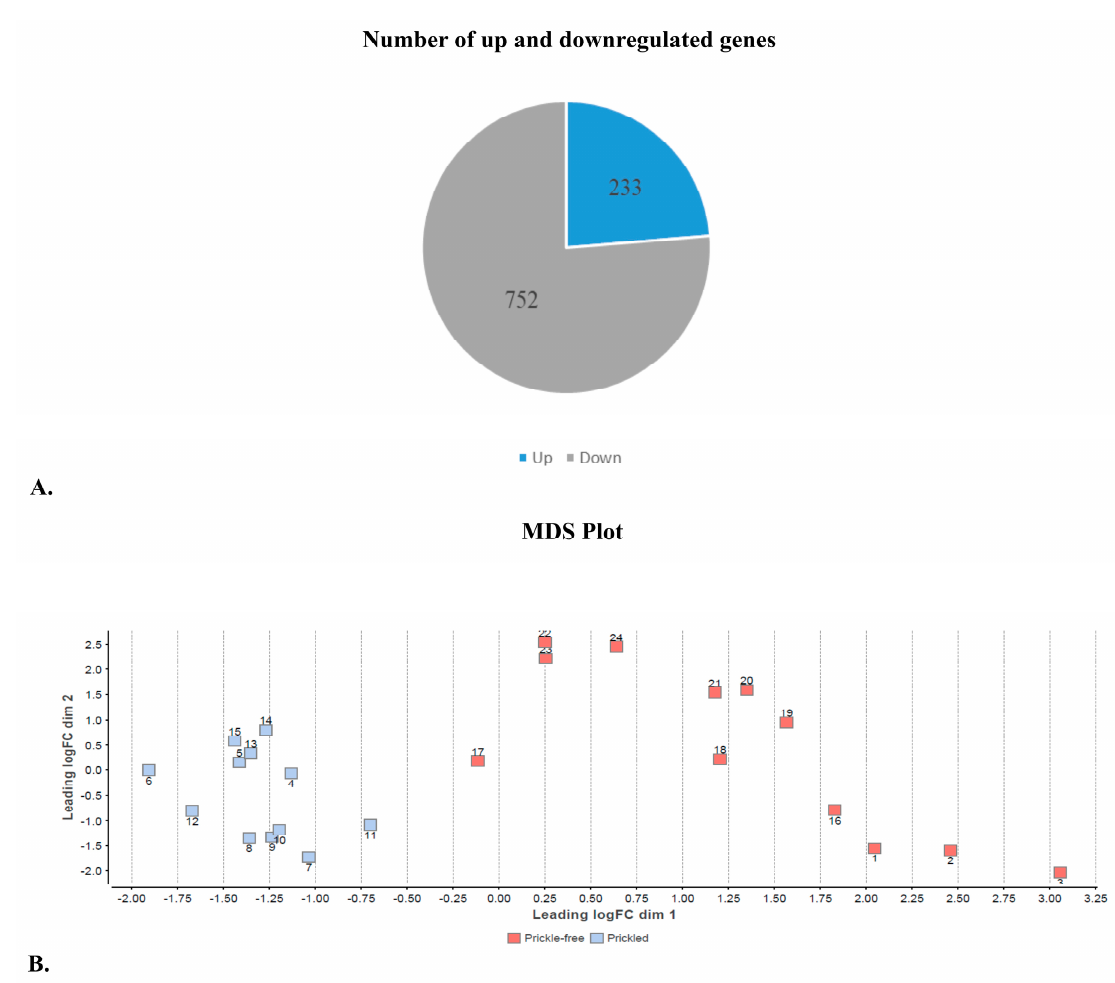
Figure 2. ( A ) Number of up and downregulated genes in the epidermis of prickle-free plants. ( B ) Multidimensional scaling plot clustering samples based on their overall similarity of gene expression patterns. This plot was created using R package DESeq2 version 1.20.0. Prickled samples formed one cluster, and prickle-free sample formed another cluster, clearly distinguishing gene expression patterns between the phenotype classes. Numbers near red and blue boxes represent the sample numbers. Axes represent first and second principal components and, therefore, have no units. Samples that are near each other in the two-dimensional space are more similar with respect to gene expressions. Table 3. List of the top 15 up- and 15 downregulated genes in the epidermal tissue of prickle-free versus prickled Rubus idaeus L. Gene IDs are based on annotation for unpublished raspberry genome assembly (Lachesis_Heritage Version 1.1) and correspond to gene descriptions in the NCBI database. NAC: N AM, A TAF1/2 and C UC2.